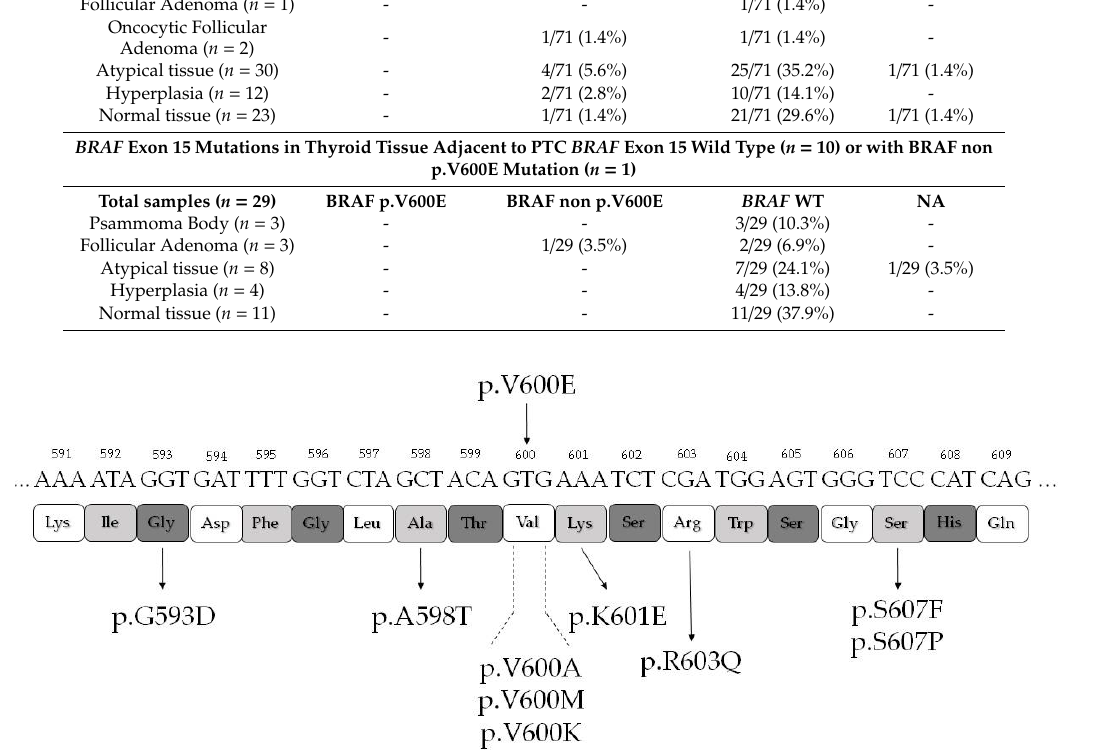
Figure 3. Schematic drawing of BRAF exon 15 mutations. The position and residue substitutions of all mutations identified are shown with respect to the standard BRAF nucleotide, codon, and amino acid residue sequence.